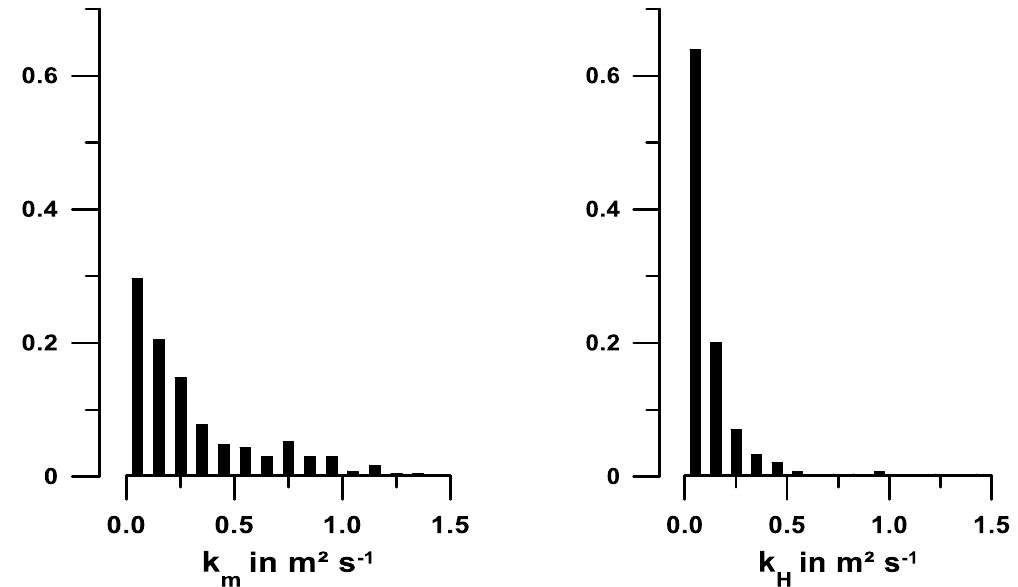
Figure A2. Relative frequency distribution of the turbulent diffusion coefficients for heat (k H ) and momentum (k m ) from aircraft data for all K1 flights (total number of values: 247; bins of 0.1 m² s −1 ).